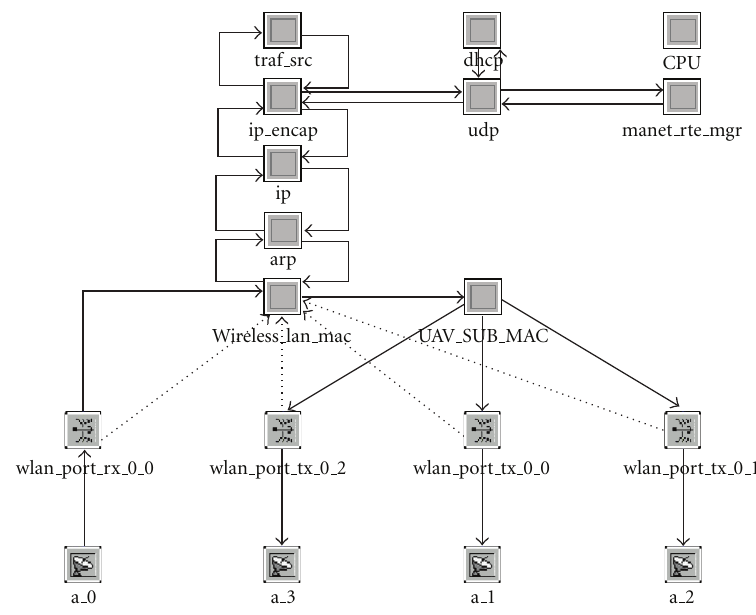
Figure 5: Modeling UAV network node in